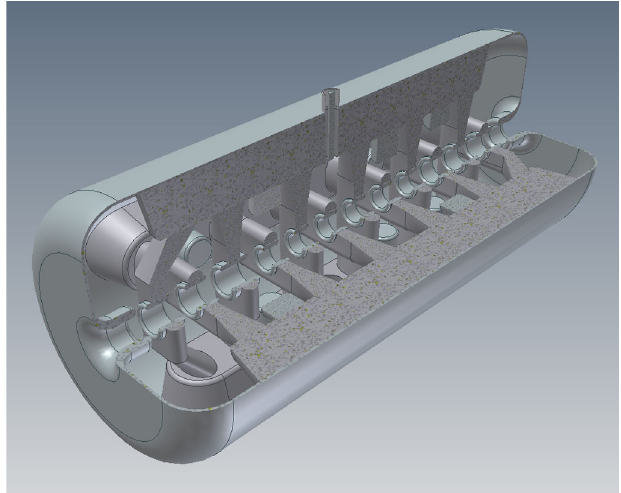
FIG. 14. (Color) Simulation of the electric field distribution before and after the optimization (above), related gap and drift tube length for the flat field (bottom).